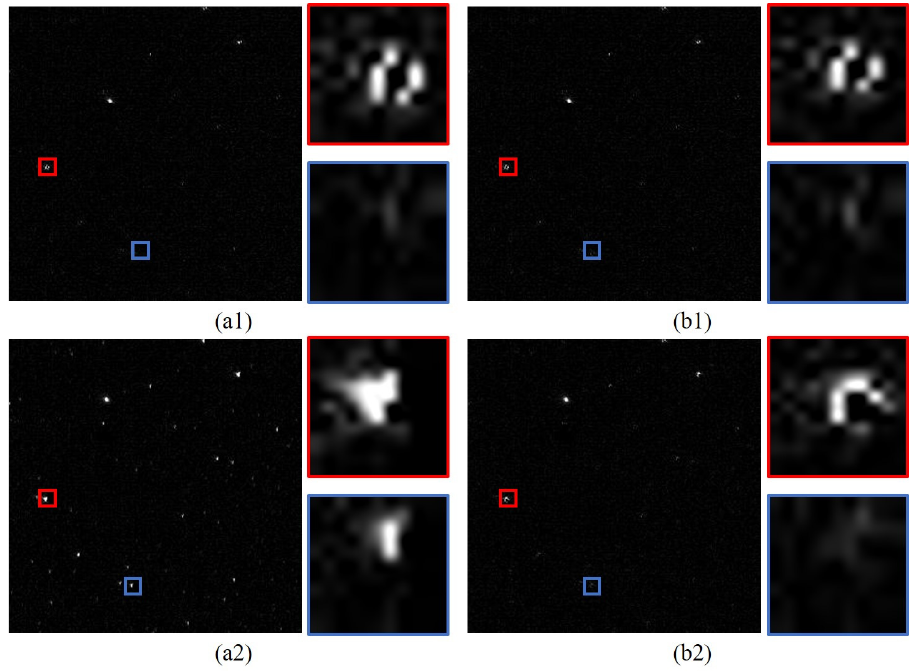
Figure 8. Region 1 in the difference images using ( a ) affine transformation and ( b ) homography transformation. ( a1 , b1 ) The difference image of the second frame and the reference image. ( a2 , b2 ) The difference image of the tenth image and the reference